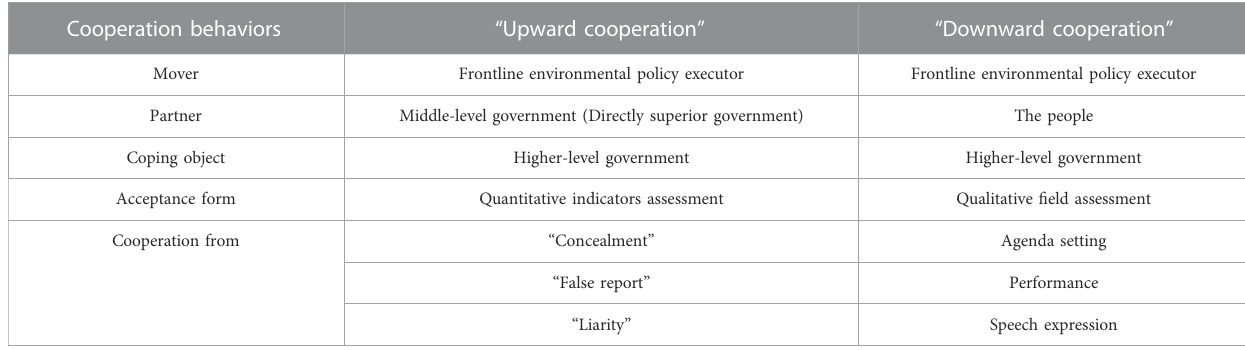
TABLE 1 Comparison of organizational characteristics between “ upward cooperation ” and “ downward cooperation ” . Cooperation